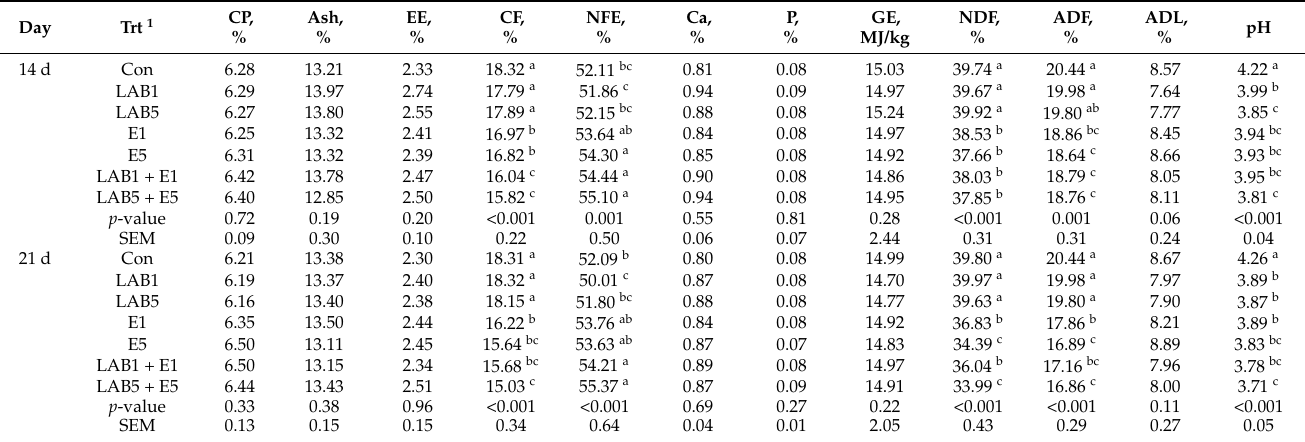
Table 3. Nutrient composition and pH of citric acid by-product at 14 and 21 days of